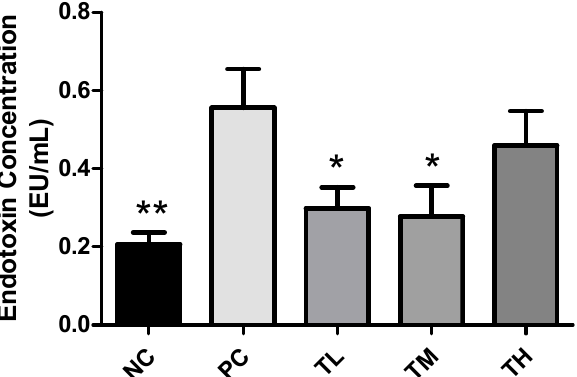
Figure 3. E ff ect of IMD on levels of endotoxin in plasma of mice with LPS-induced chronic inflammation. Results are expressed as means ± SEM of n = 4 samples for NC and PC, and n = 6 samples for TL, TM, and TH. Di ff erences in means were considered statistically significant for * p < 0.05, ** p < 0.01 relative to PC .